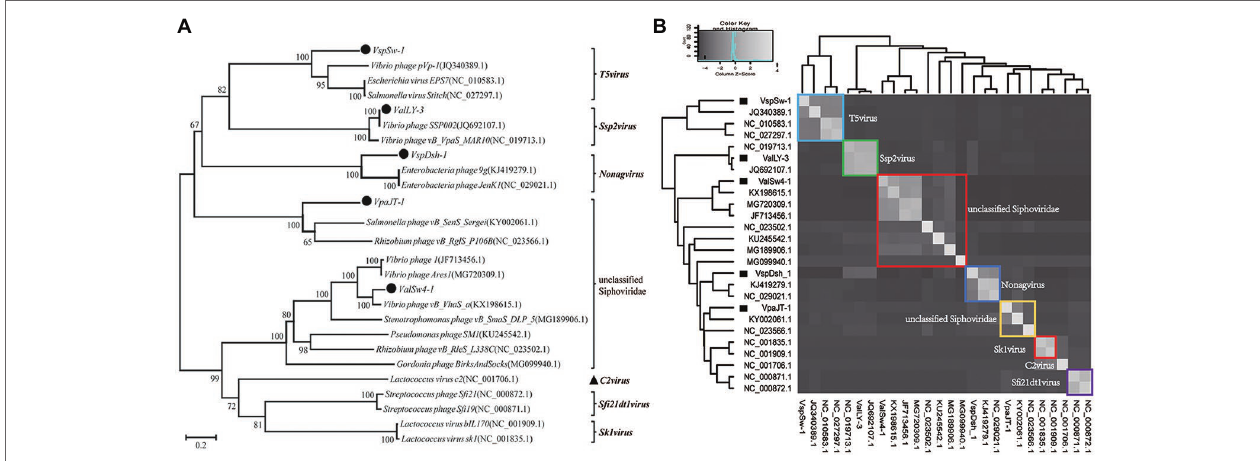
FIGURE 5 | Phylogenetic analysis of the five isolated bacteriophages. (A) Phylogenetic tree based on the sequences of the large subunits of terminases of the selected bacteriophages. The sequences of the large subunits of terminases were aligned using the Mega 5.05 program, and the phylogenetic tree was generated using the neighbor-joining method with 1,000 bootstrap replications. (B) Heat map showing percentage of the shared protein sequences among the bacteriophages.